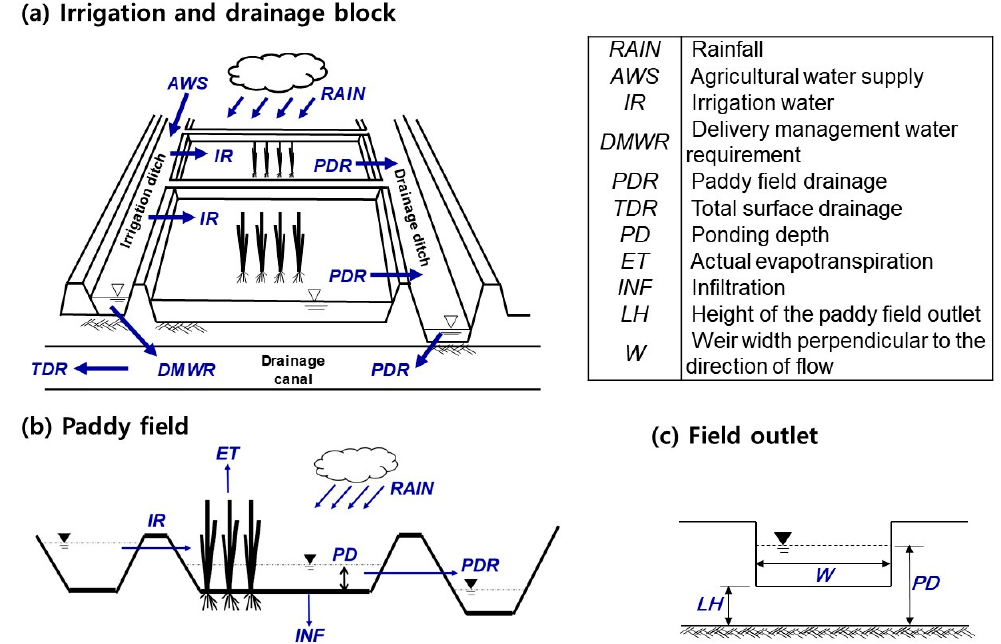
Figure 1. Schematic of the water balance in paddy fields; ( a ) irrigation and drainage block, ( b ) paddy field, and ( c ) field outlet [29].